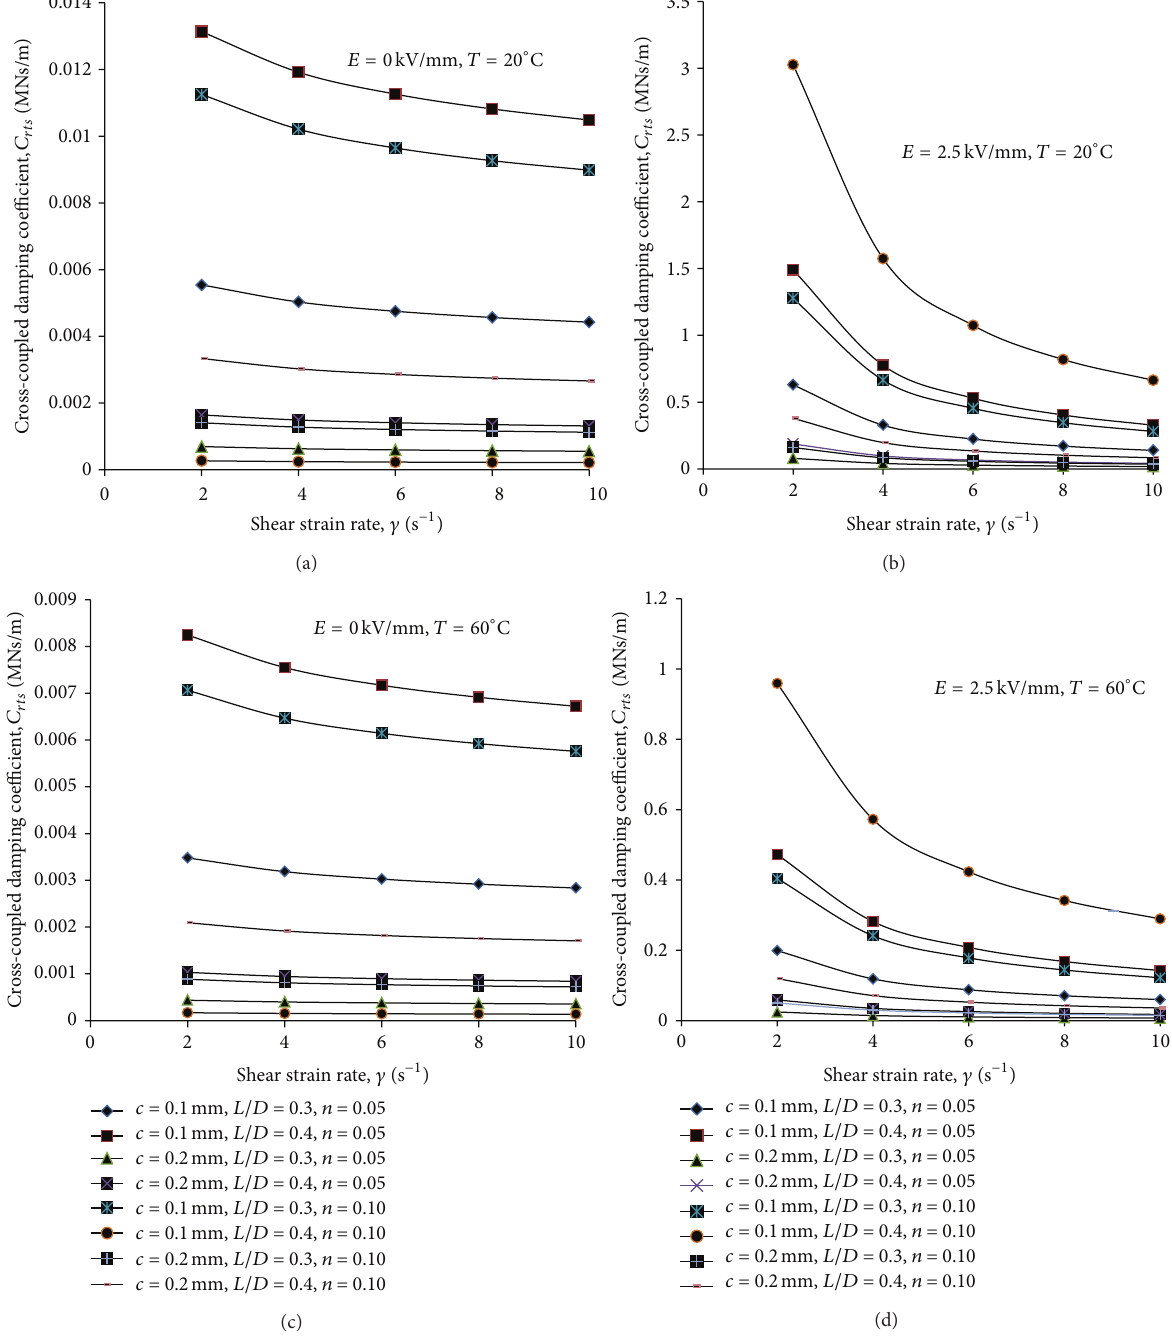
Figure 10: Cross-coupled damping coefficient, MNs/m versus shear strain rate, s −1 , for (a) 𝐸 = 0 kV/mm, 𝑇 = 20 ∘ C; (b) 𝐸 = 2.5 kV/mm, 𝑇 = 20 ∘ C; (c) 𝐸 = 0 kV/mm, 𝑇 = 60 ∘ C; and (d) 𝐸 = 2.5 kV/mm, 𝑇 = 60 ∘